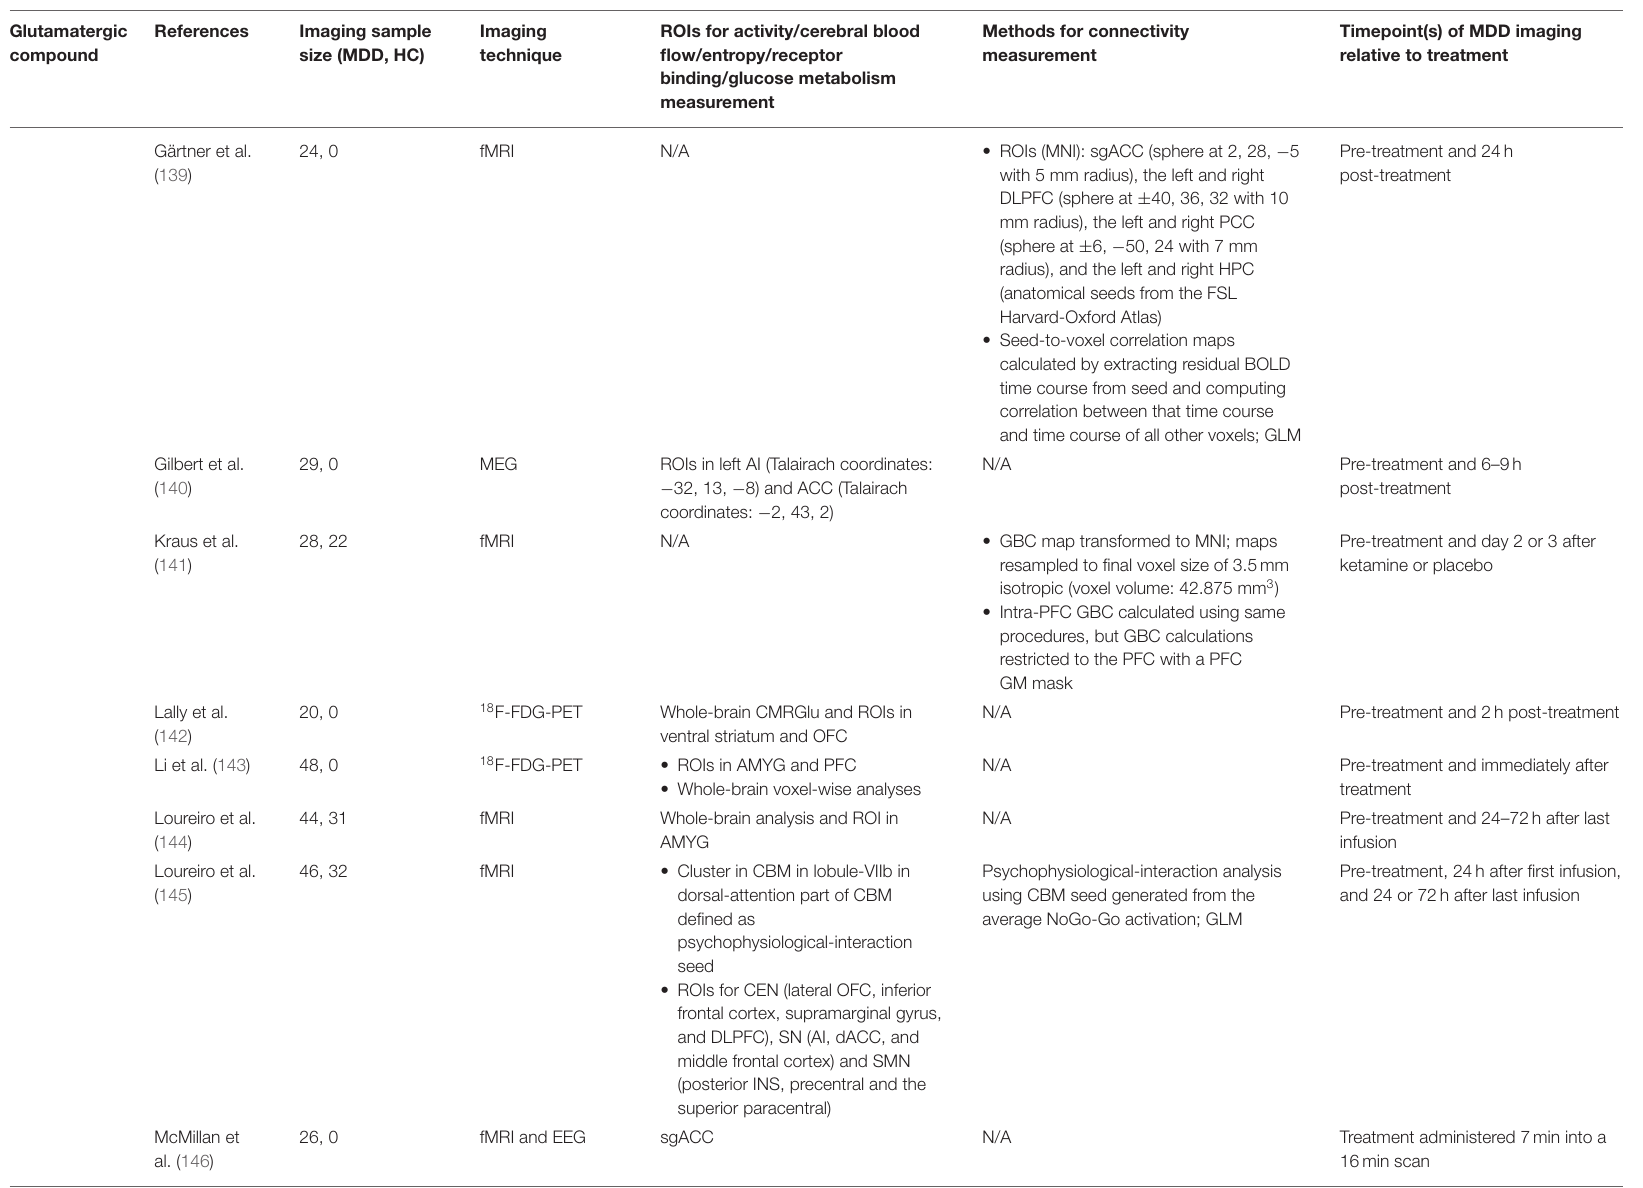
• ROIs (MNI): sgACC (sphere at 2, 28, − 5 with 5 mm radius), the left and right DLPFC (sphere at ± 40, 36, 32 with 10 mm radius), the left and right PCC (sphere at ± 6, − 50, 24 with 7 mm radius), and the left and right HPC (anatomical seeds from the FSL Harvard-Oxford